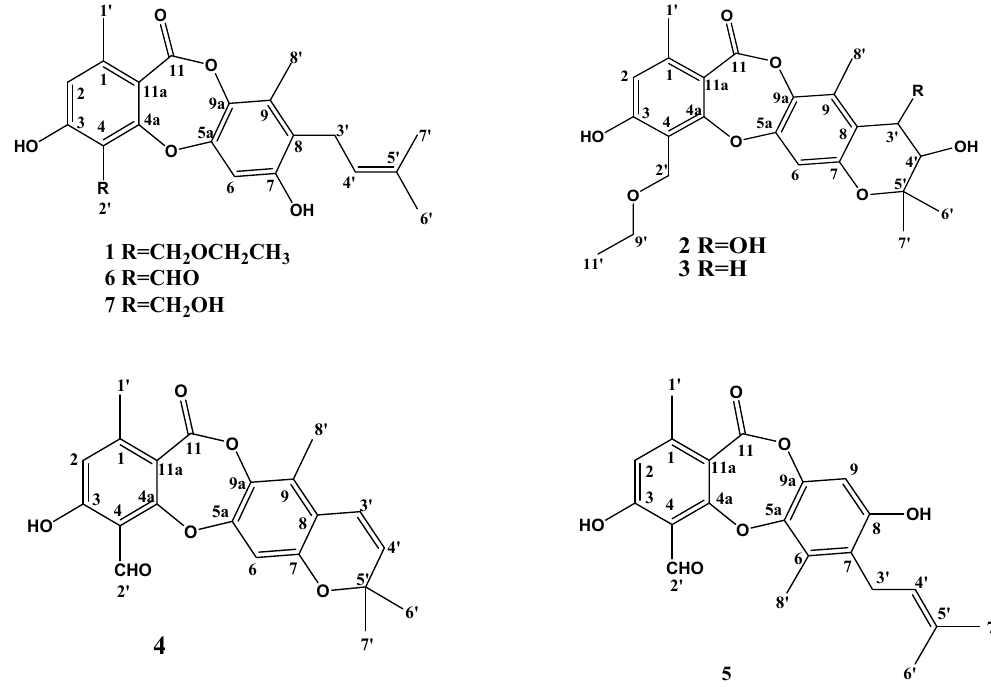
Figure 1. Chemical structures of compounds 1 – 7 .